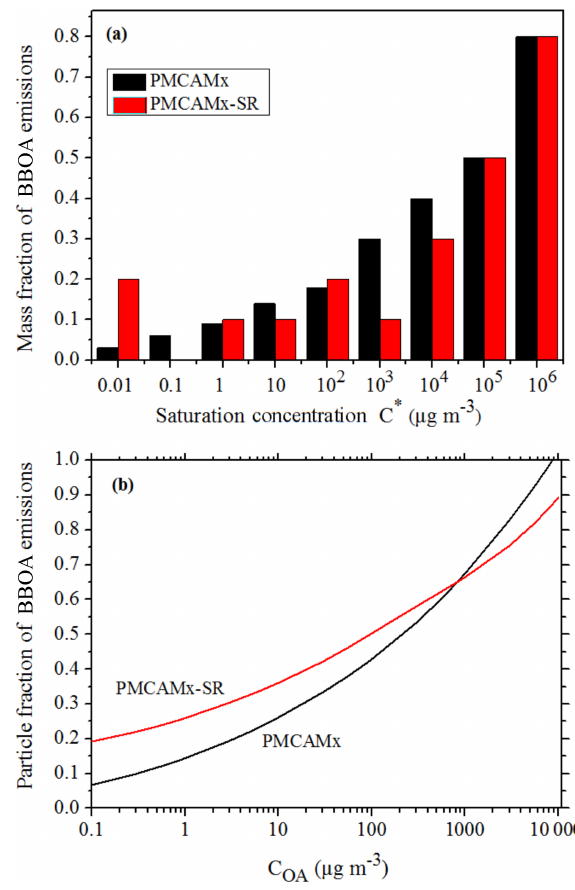
Figure 1. (a) Volatility distribution of BBOA in PMCAMx and PMCAMx-SR. (b) Particle fractions of BBOA emissions as a func- tion of OA concentration at